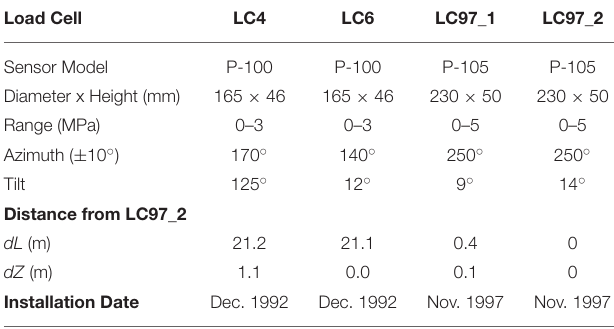
their azimuth and tilt as well as distance from LC97_2 is given in Table 1 . The load cells were installed in 1992 (LC4 and LC6) and 1997 (LC97_1 and LC97_2) at the location of pre-existing rock boreholes by melting an artificial cavity from the research shafts. pressure at the glacier bed since then.